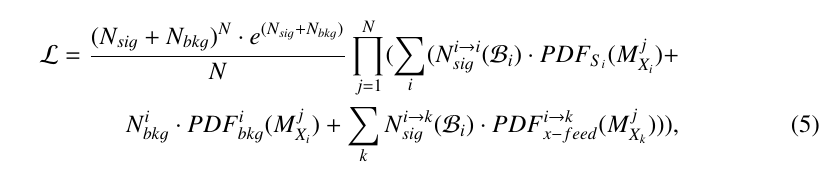
5 Numerical results for MC in the M